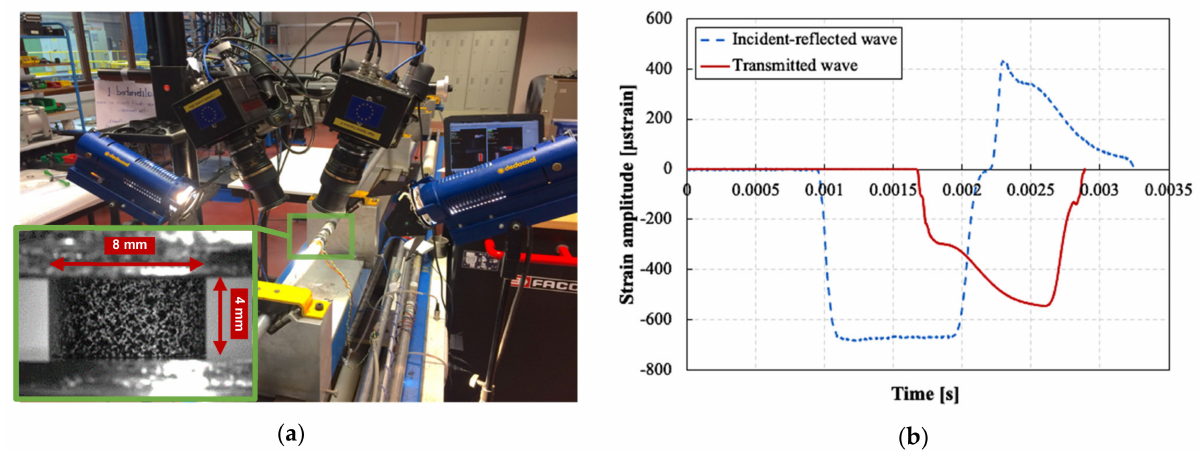
Figure 5. ( a ) High-speed 3D DIC setup used, with detail of the speckled sample (bottom left). ( b ) An example of the incident, reflected and transmitted waves recorded by strain gauges on the Hopkinson bars during a dynamic compres- sion experiment.